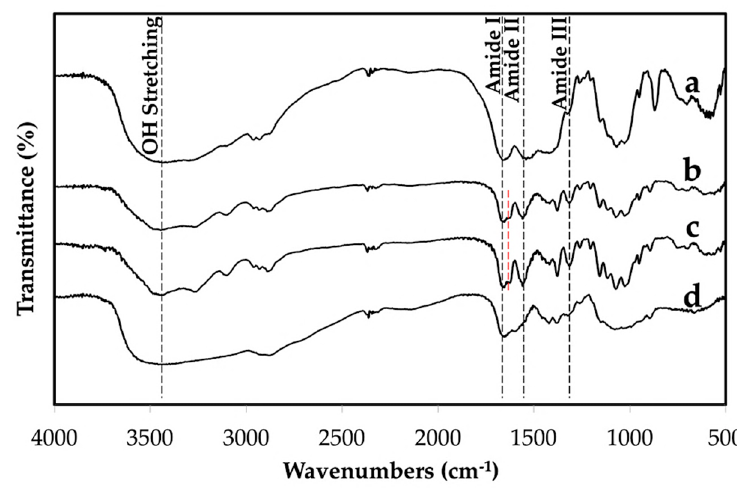
Figure 3. Fourier transform infrared (FTIR) spectra of crab shell ( a ), extracted chitin ( b ), commercial chitin ( c ), and commercial chitosan ( d ).